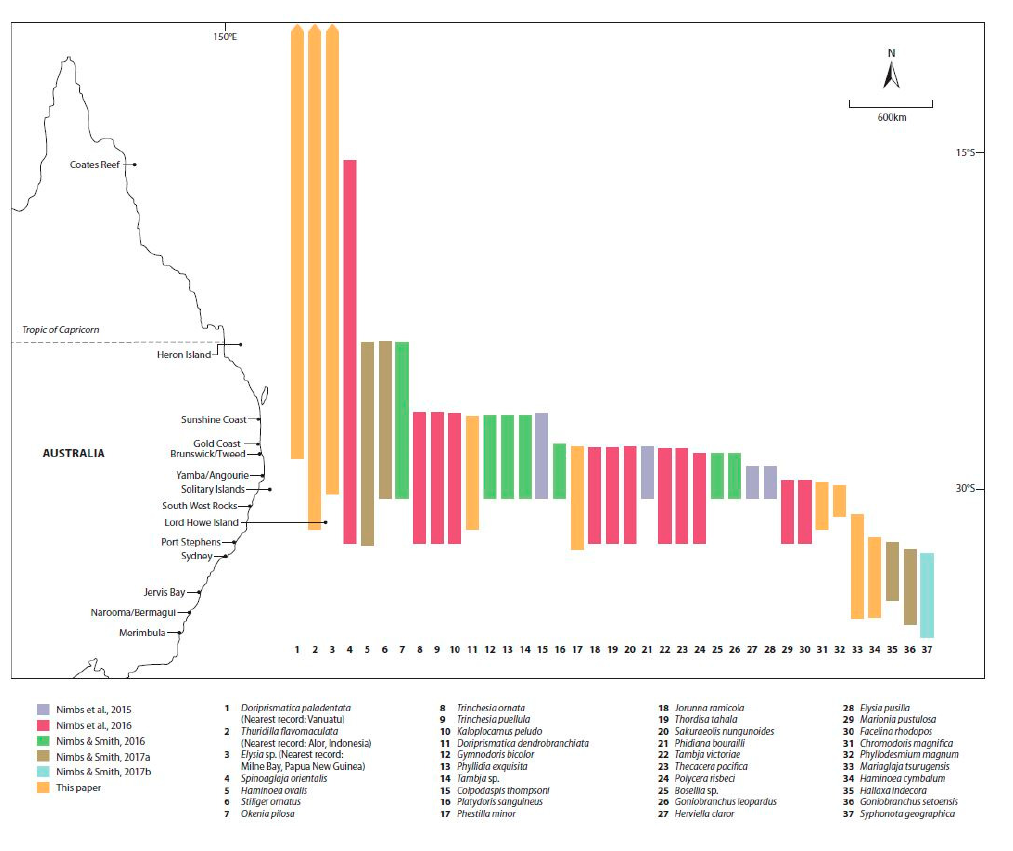
Figure 1. Summary of recent southward range extensions for sea slugs in southeastern Australia.